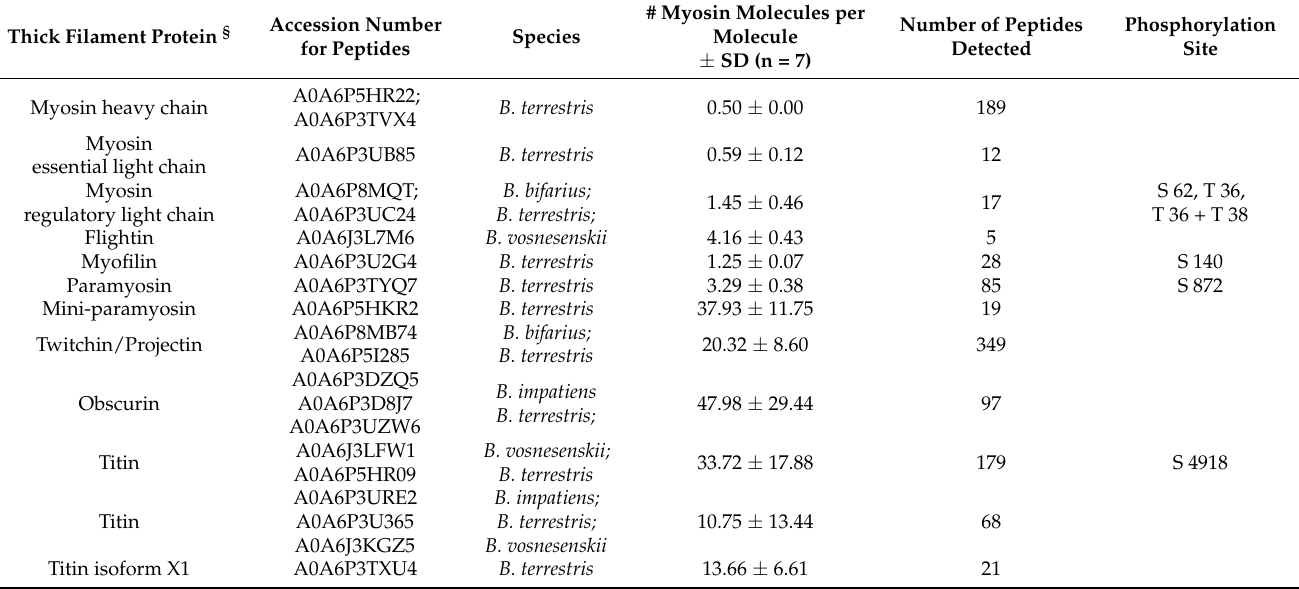
Table 2. Thick filament proteins and relative molar abundances quantified by mass